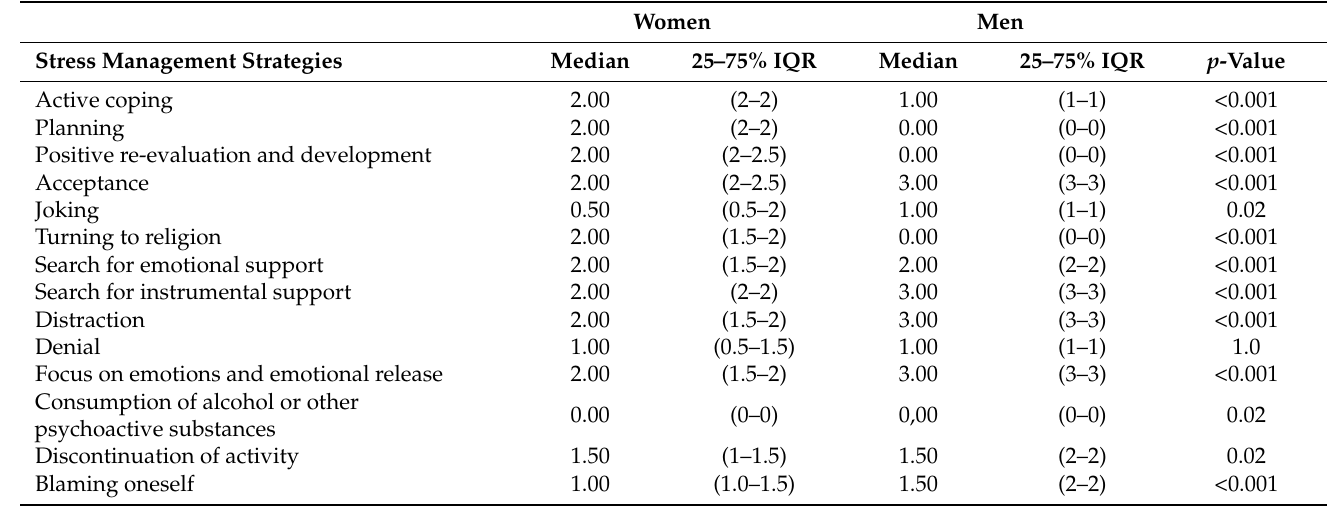
Table 2. Stress management strategies according to sex.